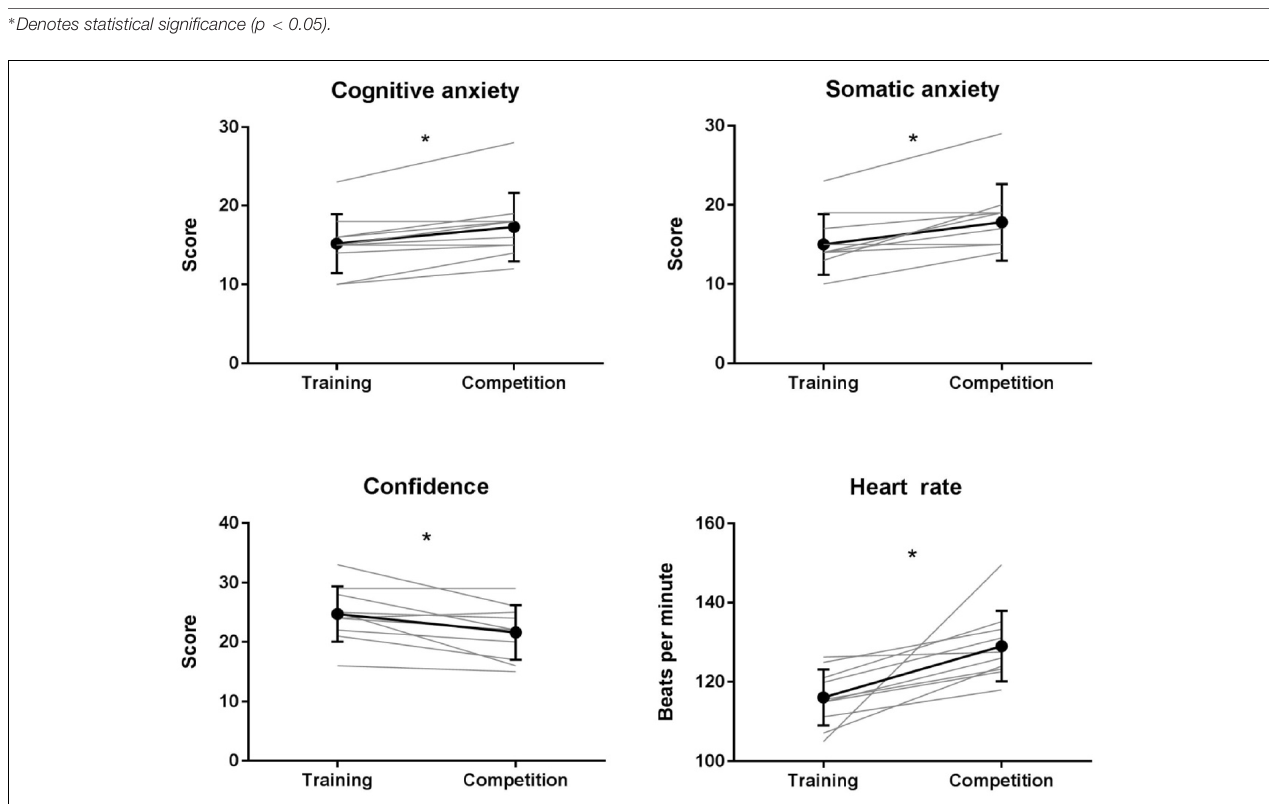
FIGURE 1 | CSAI-2 factors: cognitive anxiety, somatic anxiety and confidence, and one minute pre-fight heart rate average for training and competition fights. Mean results and standard deviations are presented in bold, individual results are presented in light gray. ∗ Indicates a significant difference between conditions ( p < 0.05).